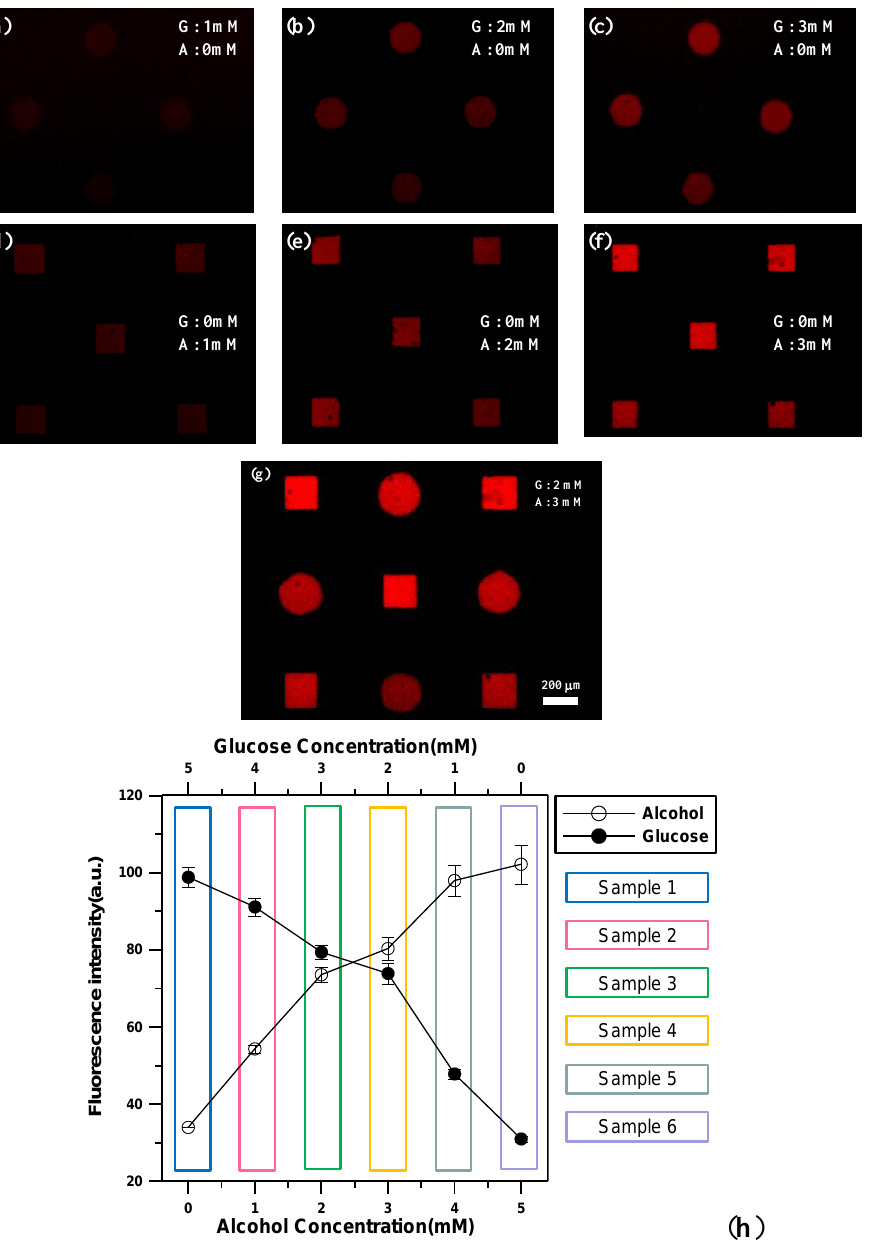
Figure 6. ( a – f ) Fluorescent images of respective detection of glucose or ethanol using shape-coded enzyme-entrapped chitosan membranes (circles: GOX/POD/AmR entrapped in chitosan membranes; squares: chitosan membranes with entrapped AOX/POD/AmR). Only the chitosan membranes entrapping a corresponding enzyme emitted red fluorescence without any cross-talk. ( g ) Fluorescent image and ( h ) intensity of simultaneous detection of glucose and ethanol using shape-coded enzyme-entrapped chitosan membranes, which were reacted with six different samples (each sample was composed of glucose and ethanol. G: glucose, A: